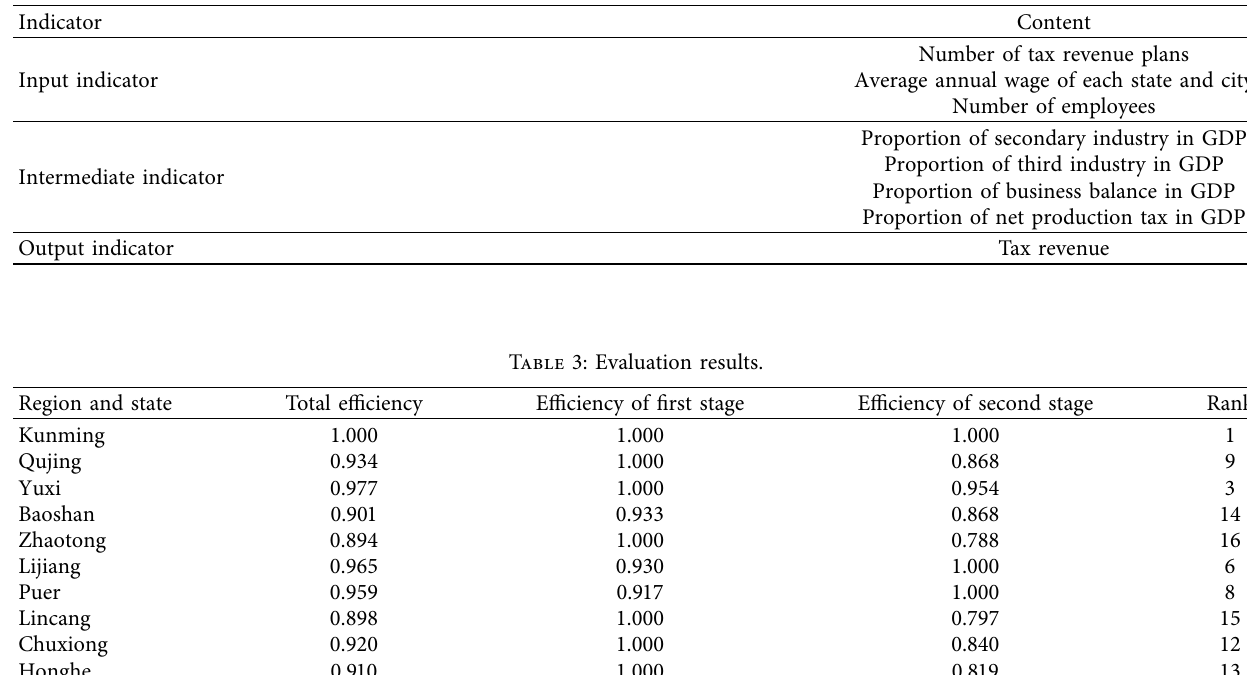
Table 2: Evaluation index system of tax collection and administration